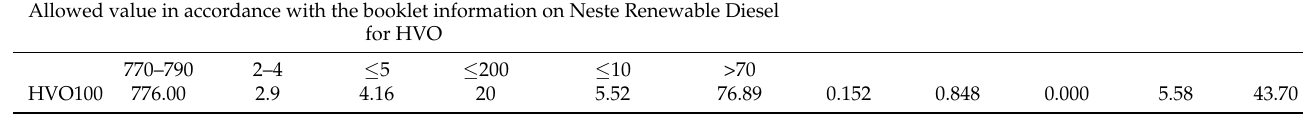
Table 1. Physicochemical properties of the analyzed fuels.